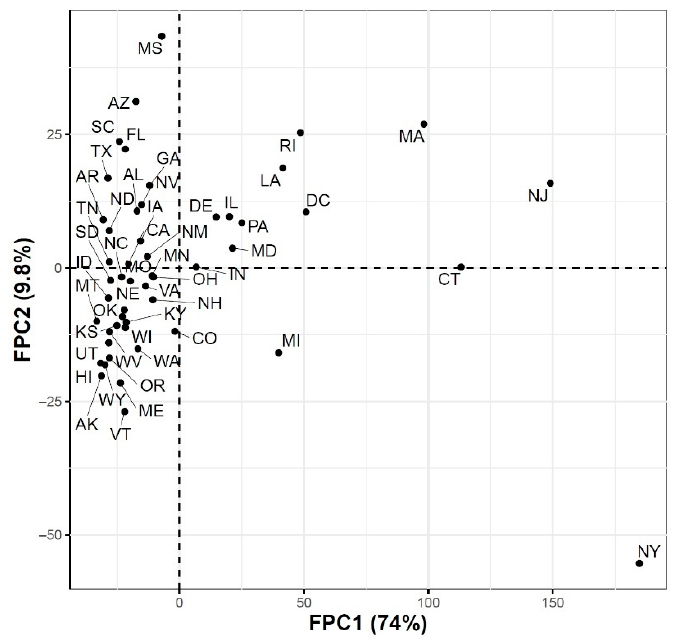
Figure 7. Scatter plot of the 51 US states in a two-dimensional space defined by the first two functional principal component scores for the COVID-19 death trajectories.